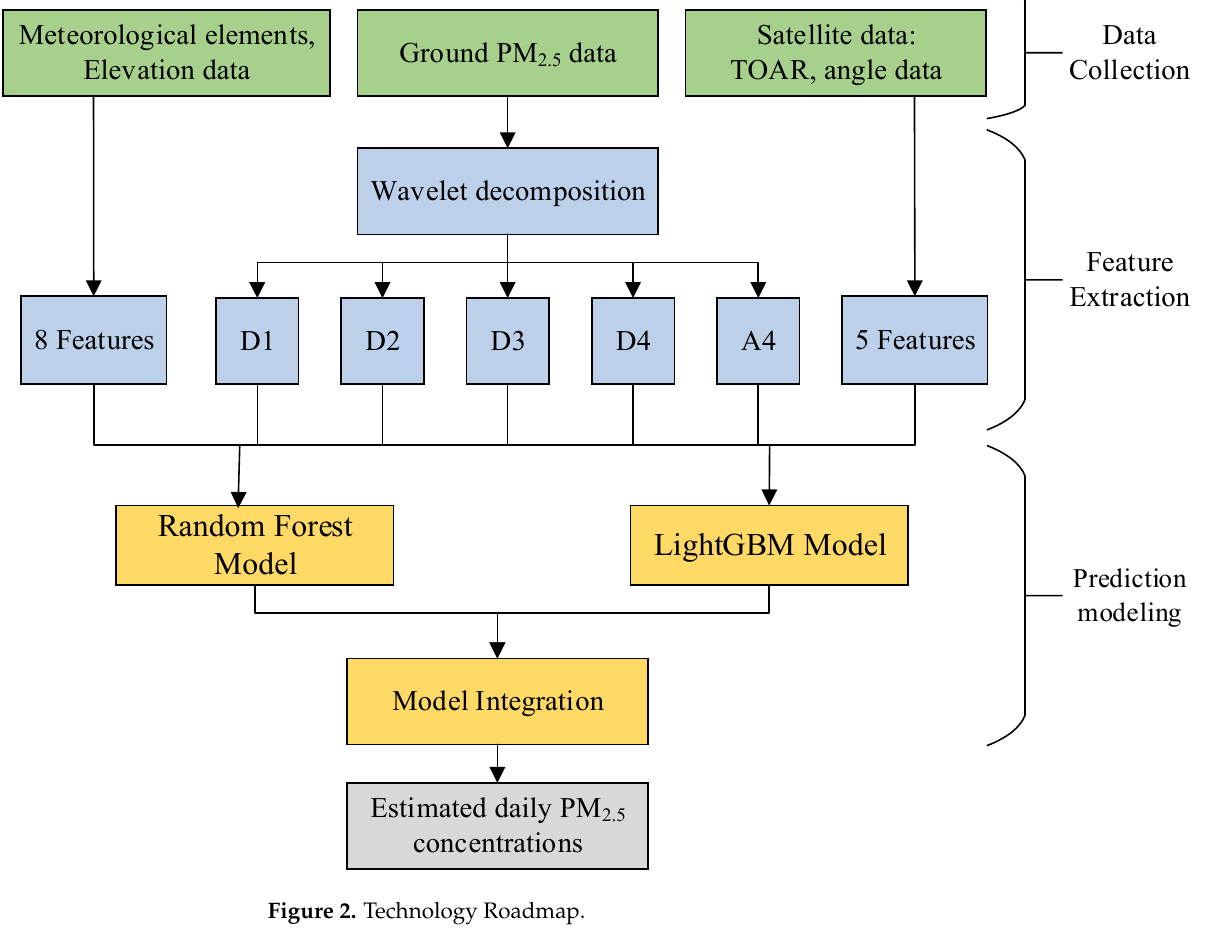
Figure 2. Technology Roadmap.